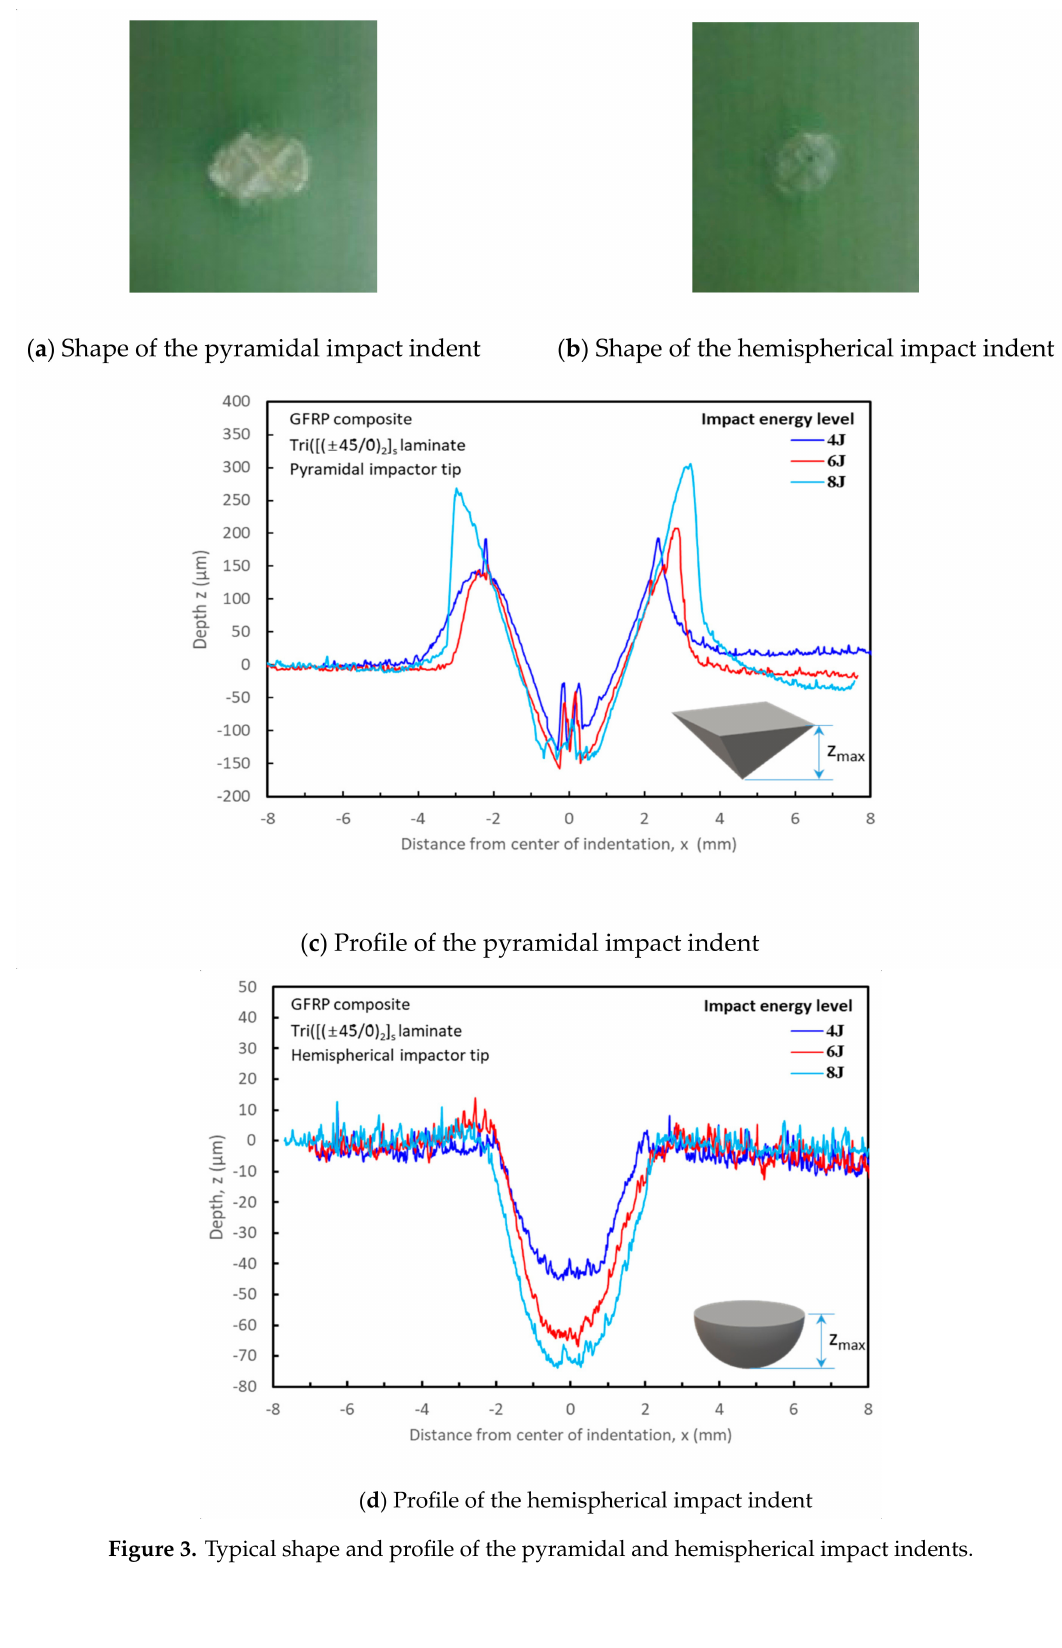
Figure 3. Typical shape and profile of the pyramidal and hemispherical impact